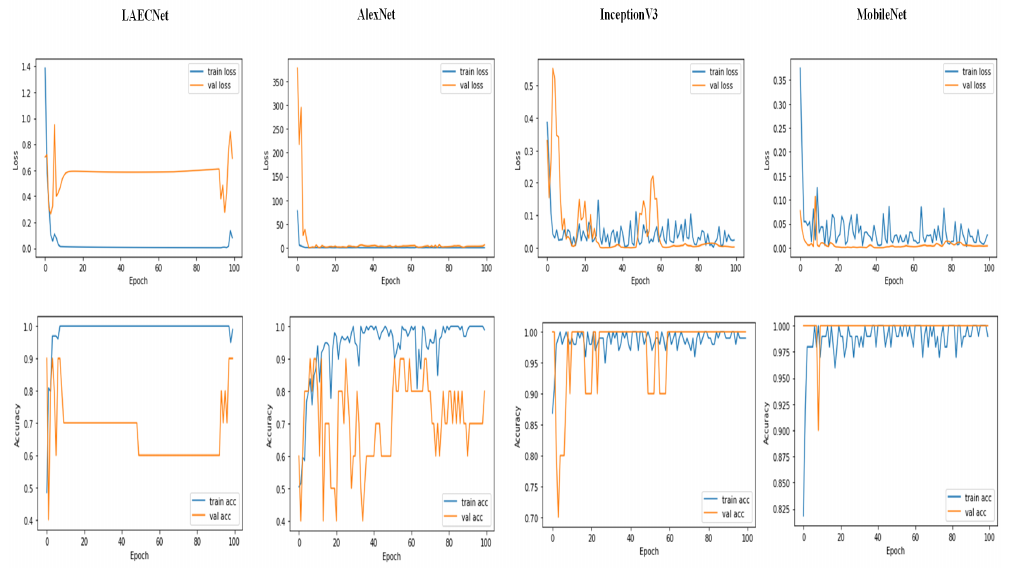
Figure 8. Losses ( upper portion ) and accuracy ( lower portion ) during training and validation.